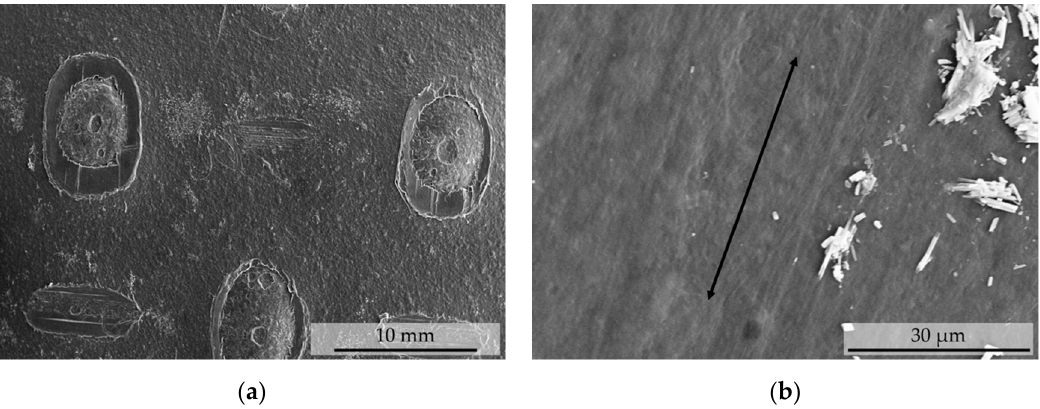
Figure 5. SEM images of the transparent collagen film. ( a ) shows a magnification of a factor of 35. Here the perforation of the film can be clearly seen. ( b ) shows a higher magnification of a factor of 50,000. The black arrow points in the unrolling direction of the collagen film. Probably during a rolling process, the film was stretched in this direction, which could have led to the structures visible here.